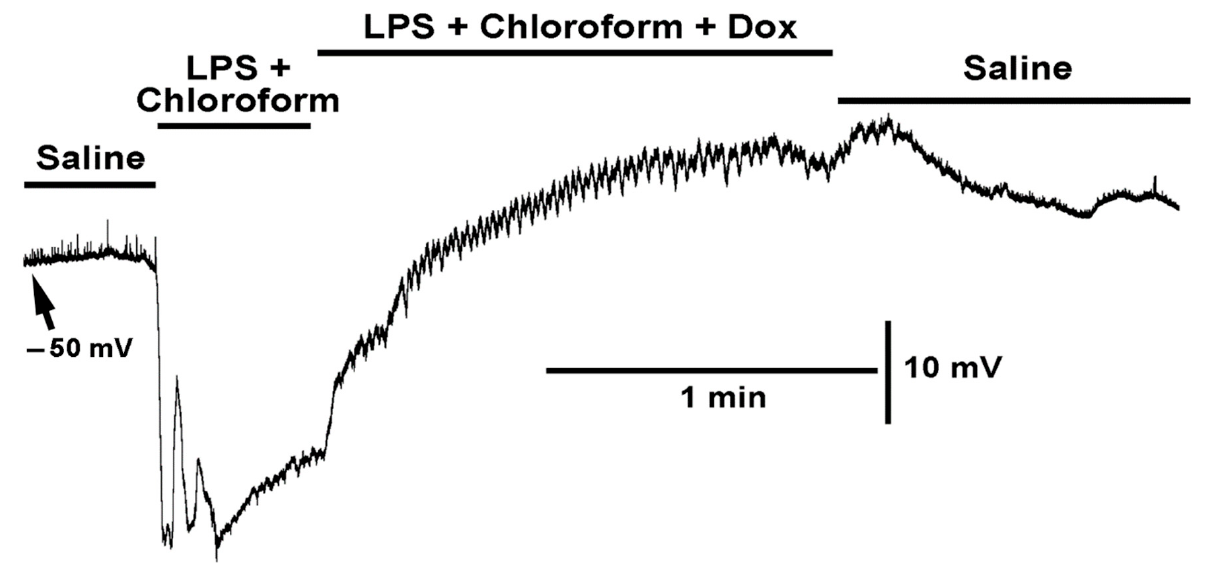
Figure 7. The effect on the resting membrane potential with exposure to LPS combined with chloroform (0.2%) and LPS combined with both chloroform (0.2%) and doxapram (10 mM). The combined LPS with chloroform still produced rapid hyperpolarization, but with some rapid depolarizations which is unlike LPS exposure by itself. LPS combined with both chloroform and doxapram rapidly depolarized the membrane and resulted in waves on contraction. The effects of the cocktail can partially be reversed by saline wash.